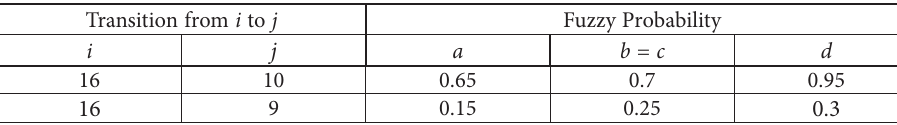
Table 6. Fuzzy probabilities Transition from i to j